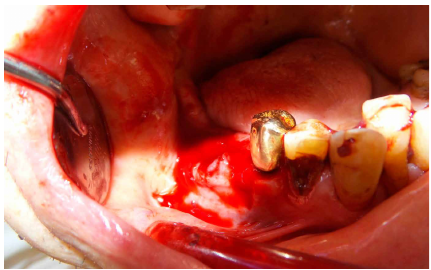
Figure 1: Oral bleeding after removal of the first and second